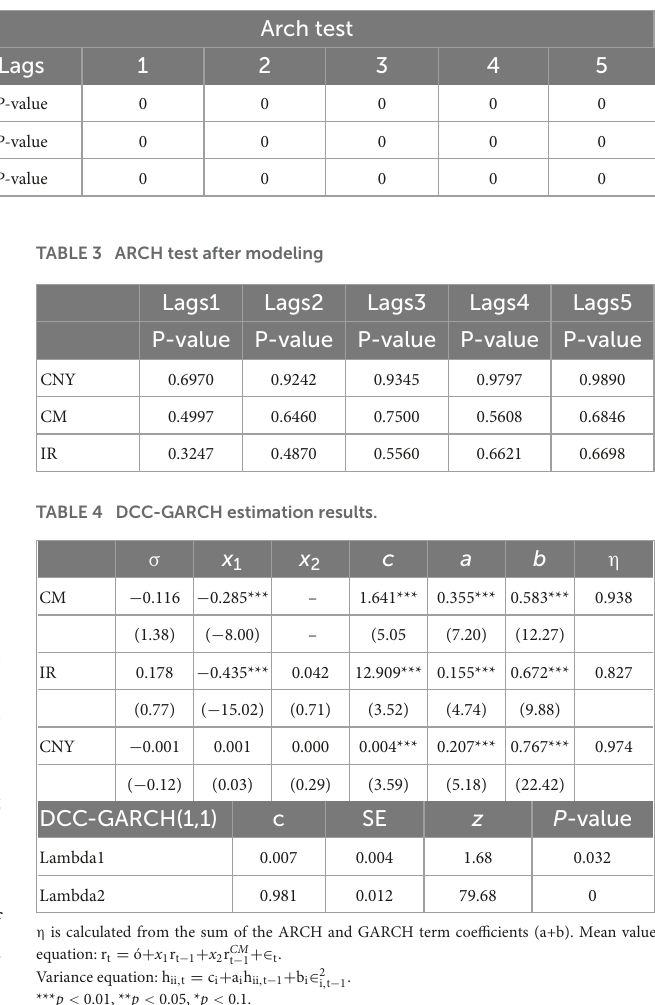
TABLE 2 Tests of stability and ARCH.